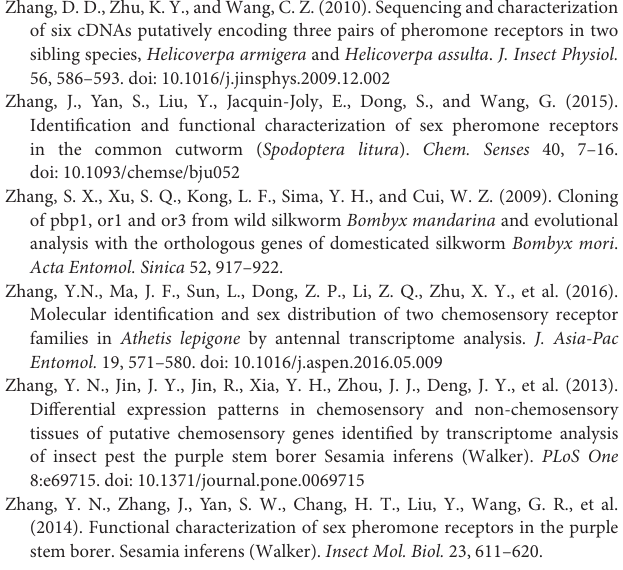
FIGURE 3 | Predicted structure of Lepidopteran SPRs BmOR3 and Orcos through SwissModel. In total, 7 transmembrane helixes were colored rainbow in the form of silk ribbon (Cartoon) and